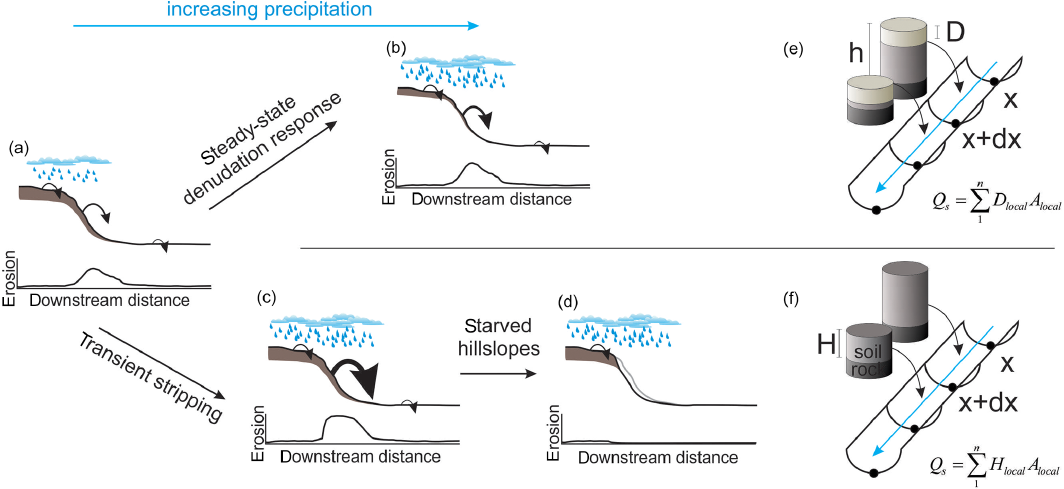
Figure 6. Conceptual model of two modes of hillslope response to increased precipitation in semi-arid environments. Arrow size represents the relative contribution of eroded hillslope sediment to the river. In the steady-state case (a, b) , increased precipitation results in increased hillslope erosion rates on steep hillslopes which are balanced by increased soil production (see, e.g., Norton et al., 2014). In the transient case (a, c, d) , increased precipitation results in rapid stripping of hillslope sediment as debris flows and shallow landslides (c) occur, followed by negligible erosion on steep hillslopes once the soil mantle is eroded (d) . The model setup for each of these scenarios is shown in (e) (steady state) and (f) (transient stripping). The steady-state model (e) calculates the sediment load Q s as the sum of sediment delivered by erosion (erosion rate × time step × local area) at each node. To model transient hillslope stripping, we remove the entire soil thickness (soil thickness × time step × local area) at each node. These model setups provide endmember scenarios for hillslope response to changing climate.